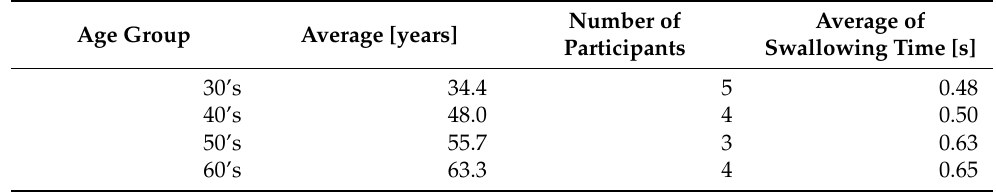
Figure 10. Sensor response with laryngeal movements for different age groups: ( a ) optical loss values for males in their 30s; ( b ) differential values of males in their 30s; ( c ) optical loss values for males in their 60s; ( d ) differential values of males in their 60s; ( e ) optical loss values of female subjects; ( f ) differential values of female subjects. Table 2. The average age, the number of participants, and the average swallowing times for each age group of male